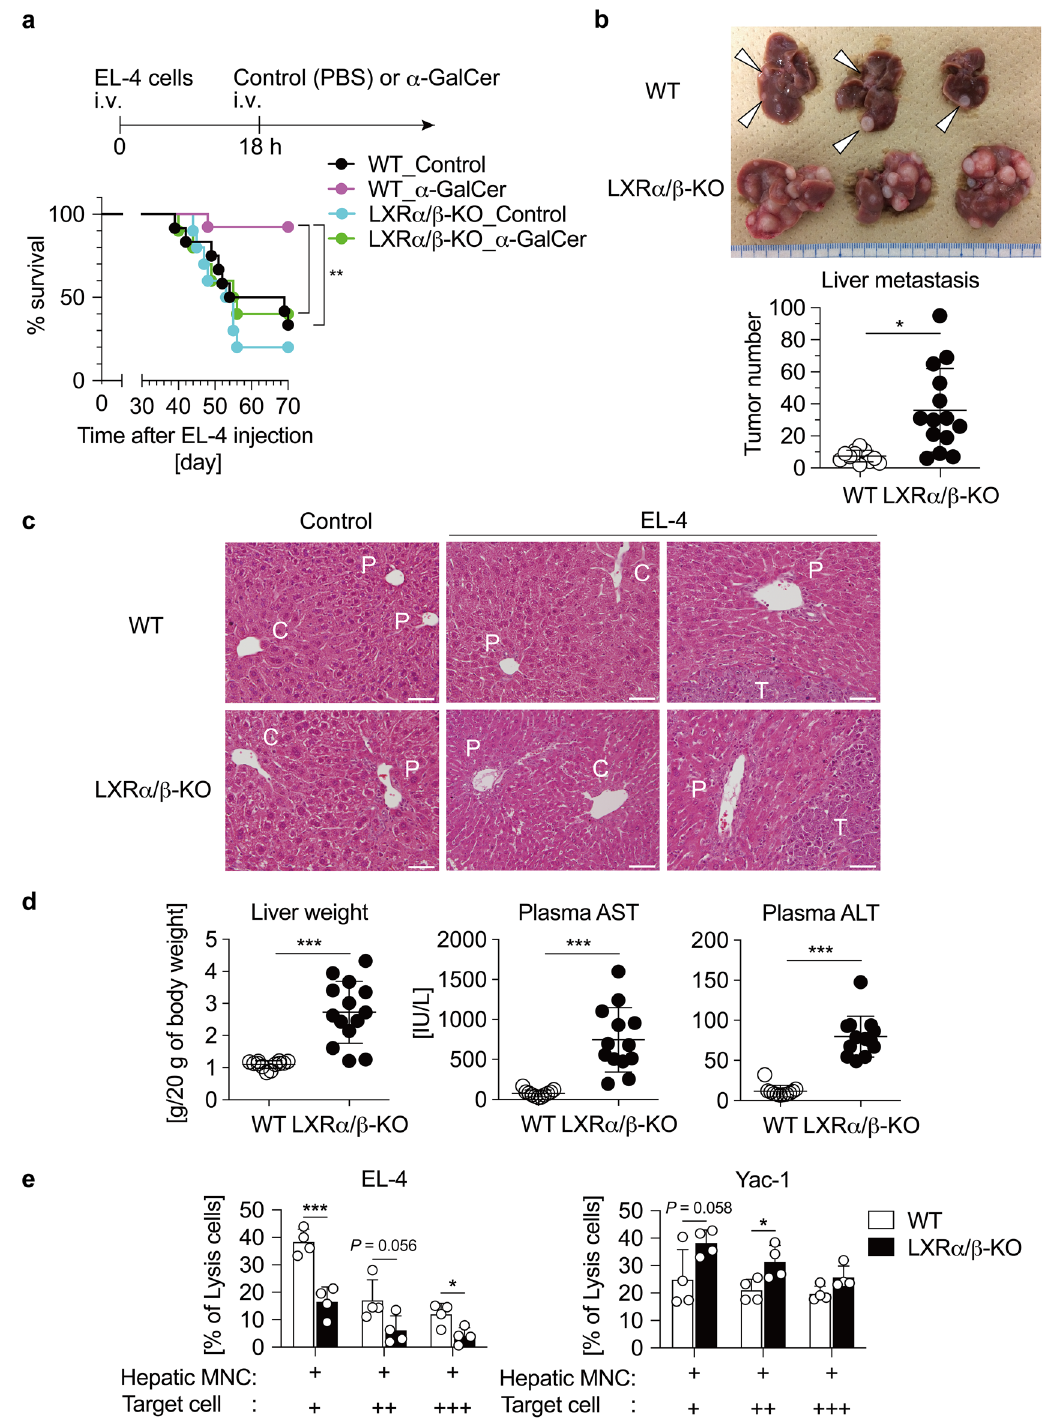
Figure 4. NKT cell-mediated antitumor immunity is impaired in LXRα/β-KO mice. ( a ) Survival rate of mice inoculated with EL-4 tumor cells. WT and LXRα/β-KO mice were injected with EL-4 cells (5 × 10 5 cells/20 g of body weight), and 18 h later treated with vehicle control (phosphate buffered saline) or α-GalCer (0.1 mg/kg of body weight) intravenously (n = 10–13 for each group). ** P < 0.01 (Log-rank test). ( b ) Liver metastasis in mice inoculated with EL-4 cells. The number of metastasis was counted in the liver of WT and LXRα/β-KO mice 28 days after injection of EL-4 cells (1 × 10 6 cells/20 g of body weight). Arrow heads in the photo indicate metastatic tumors in WT mice. * P < 0.05 (Mann–Whitney’s test). ( c ) Hematoxylin and eosin staining of the liver. The labels C, P and T indicate central vein, portal vein and tumor, respectively. ( d ) Liver weight, plasma aspartate aminotransferase (AST) and alanine aminotransferase (ALT) in mice inoculated with EL-4. *** P < 0.001 (Student’s t test). ( e ) Cytotoxicity activity of hepatic MNCs. Hepatic MNCs were isolated form WT and LXRα/β-KO mice, and co-cultured with different concentrations of calcein-labeled EL-4 cells or Yac-1 cells (+ , 5 × 10 4 cells/well; + + , 1 × 10 5 cells/well; + + + , 2 × 10 5 cells/well). After incubation for 4 h, fluorescent intensity in the culture media was measured for cell lysis (n = 4). * P < 0.05, *** P < 0.001 (Student’s t